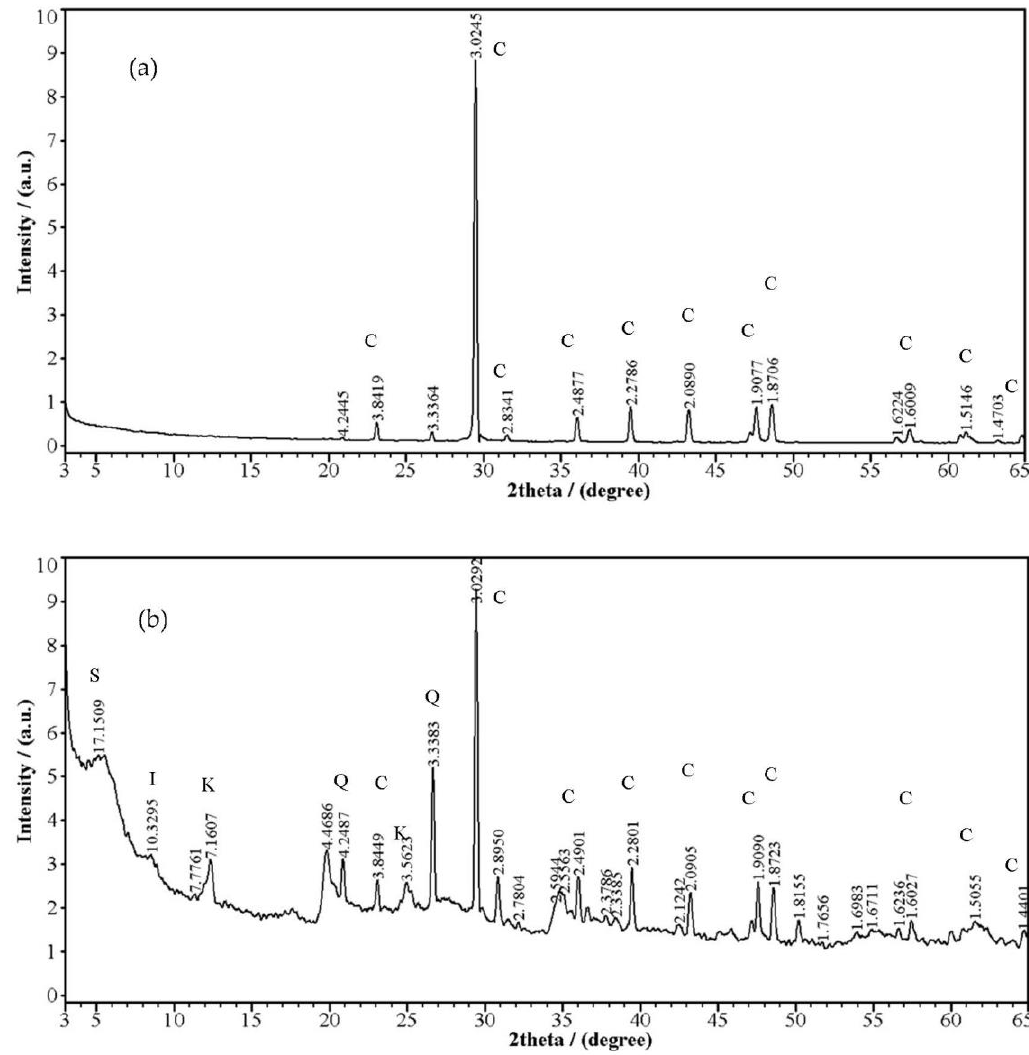
Figure 2. XRD patterns of sample AG-1 ( a ) and AG-4 ( b ). The XRD patterns of AG-2, CA-5, CA-6, and CA-7 are almost identical to the XRD pattern of AG-1, and the XRD patterns of CA-8 and AG-3 are almost identical to the XRD pattern of AG-4. Please note that for Figure 2a, sample is under the boundary layer, while for Figure 2b sample is right on the boundary layer. The letters C, I, K, Q, and S represent calcite, illite, kaolinite, quartz, and smectite.